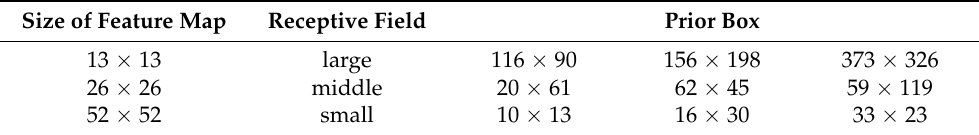
Table 2. Corresponding between feature graph size and prior